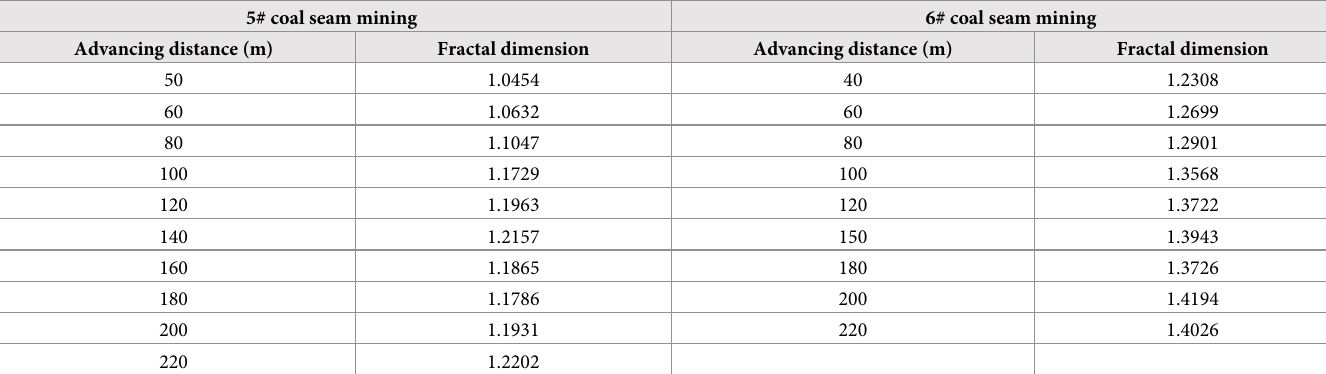
Table 2. Fractal dimension of overburden fissures.